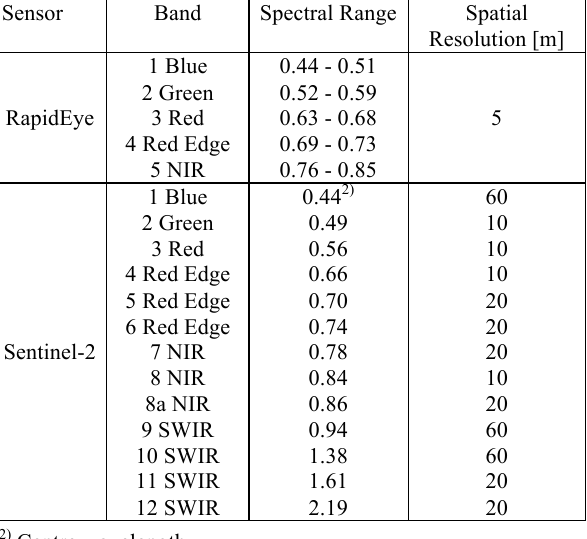
Table 1. Sensor parameters for images used in experiments